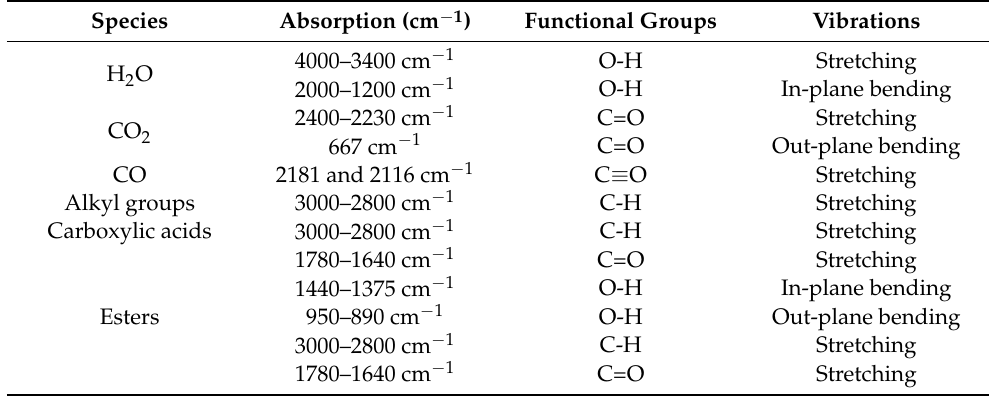
Table 5. IR absorption bands for the volatile gas products from cold-rolling oil sludge pyrolysis and the corresponding vibration types of the species.